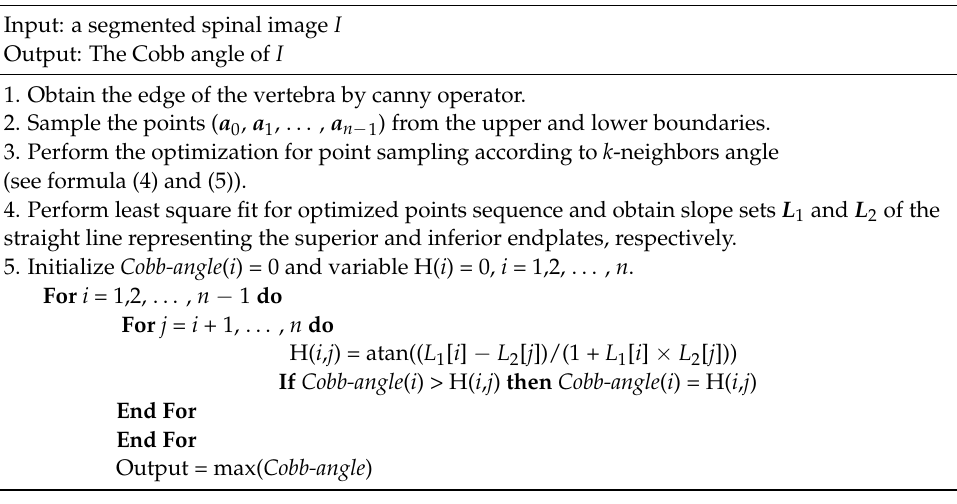
Figure 6. Automatic measurement of Cobb angle. L 1 [ i ] denotes the slope of the straight line repre- senting the superior endplate of the i -th vertebra; L 2 [ i ] denotes the slope of the straight line representing the inferior endplate of the i -th vertebra; H ( i , j ) denotes the angle between the superior endplate of the i -th vertebra and the the inferior endplate of the j -th vertebra. Algorithm 1. Automatic measurement of Cobb angle.